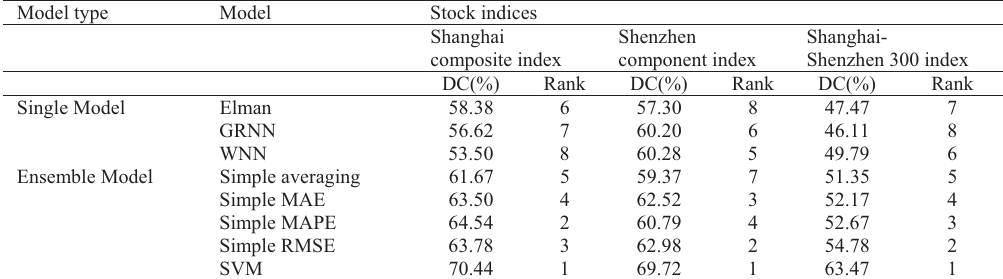
Table 5. Comparison of performance of DC averaging each model over 20 runs.